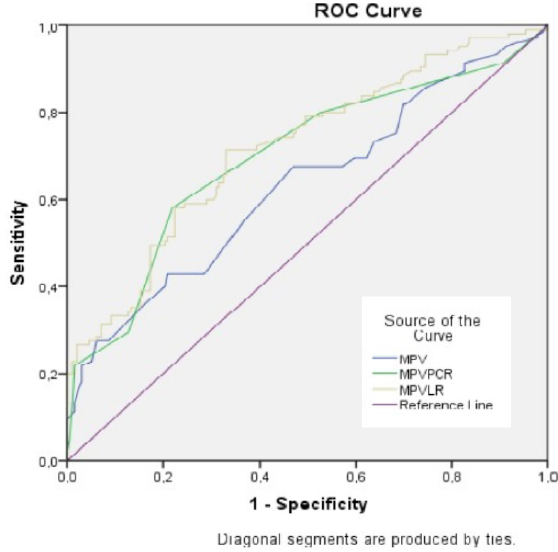
Fig. 1 – Mean platelet volume (MPV), mean platelet volume-to- platelet count ratio (MPVPCR), mean platelet volume-to-lymphocyte ratio